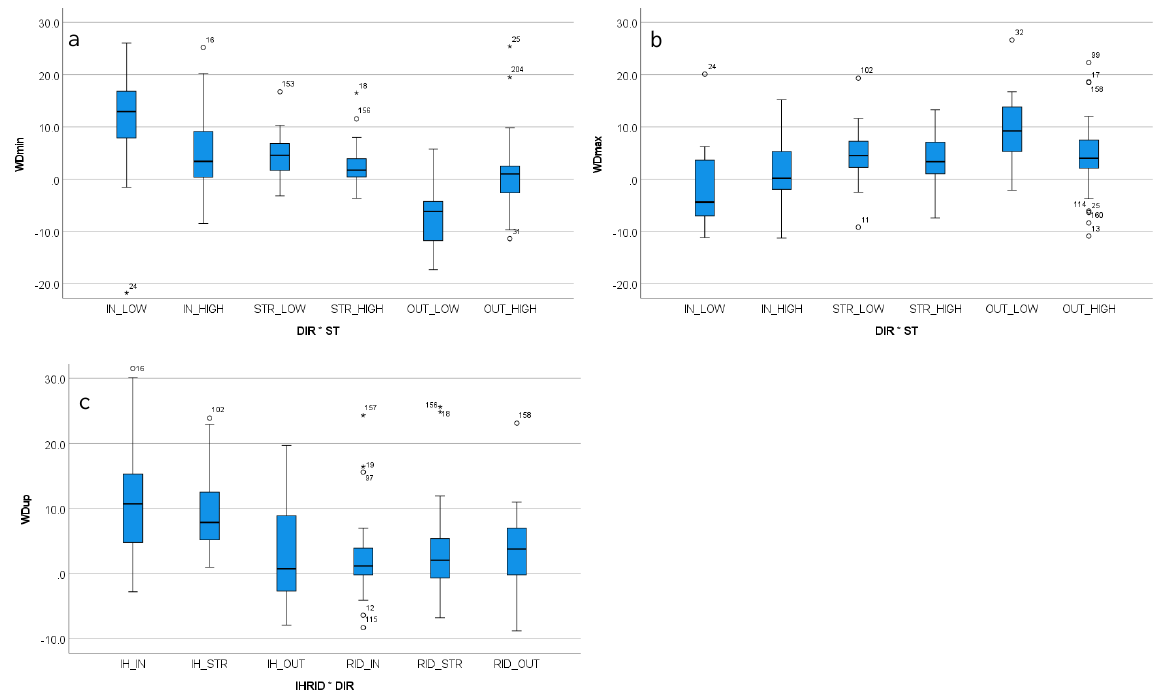
Figure 4. Box plots for significant two-way interactions for withers movement asymmetry ( a ) WDmin, ( b ) WDmax, ( c ) WDup. WDmin and WDmax are significantly affected by the two-way interaction of movement direction with stride time, WDup is significantly affected by the two-way interaction of in-hand versus ridden exercise with movement direction. All movement asymmetry parameters are shown in mm. WDmin: minimum difference for vertical withers movement; WDmax: maximum difference for vertical withers movement; WDup: upward movement amplitude difference for vertical withers movement; IN: inside rein; OUT: outside rein; HIGH: higher than average stride time; LOW: lower than average stride time. Outliers ‘ ◦ ’ defined as data points more extreme than first quartile − 1.5 times interquartile range or more extreme than third quartile +1.5 times interquartile range. Extreme outliers ‘*’ defined as data points more extreme than first quartile − 3 times interquartile range or more extreme than third quartile +3 times interquartile range.